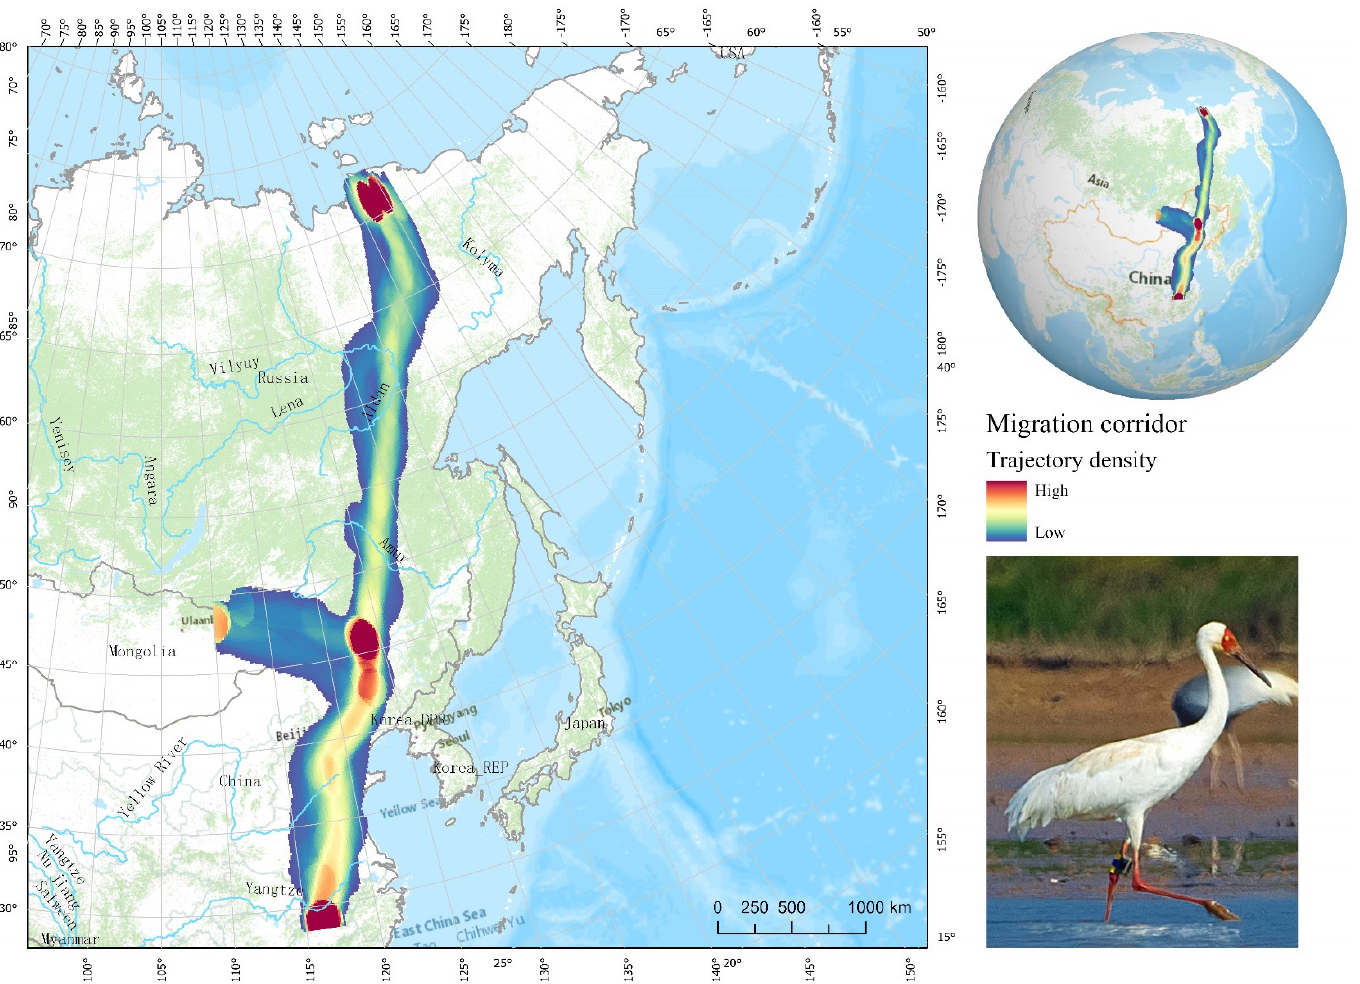
Figure 3. Mapping of Siberian crane ( Leucogeranus leucogeranus ) migration corridors, based on trajectories of the density estimation summarization of the migration routes of four tracked individuals. Bird SC1902, with our satellite logger, was sighted and photographed by a birdwatcher (Xiaohua Wang) at Poyang Lake on 15 March 2021, 649 days after being tracked on 5 June 2019.